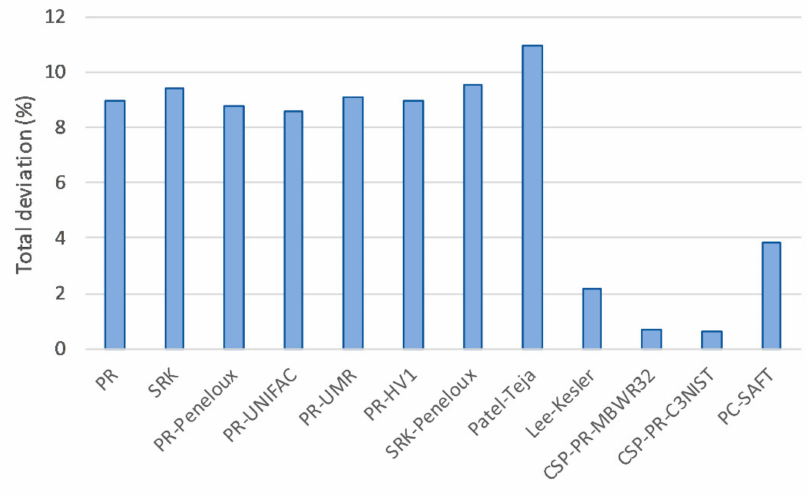
Figure 5. Total deviation relative to GERG.